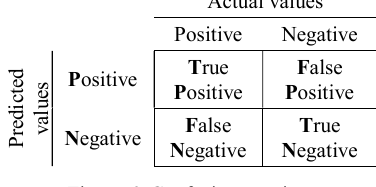
Figure 6. Confusion